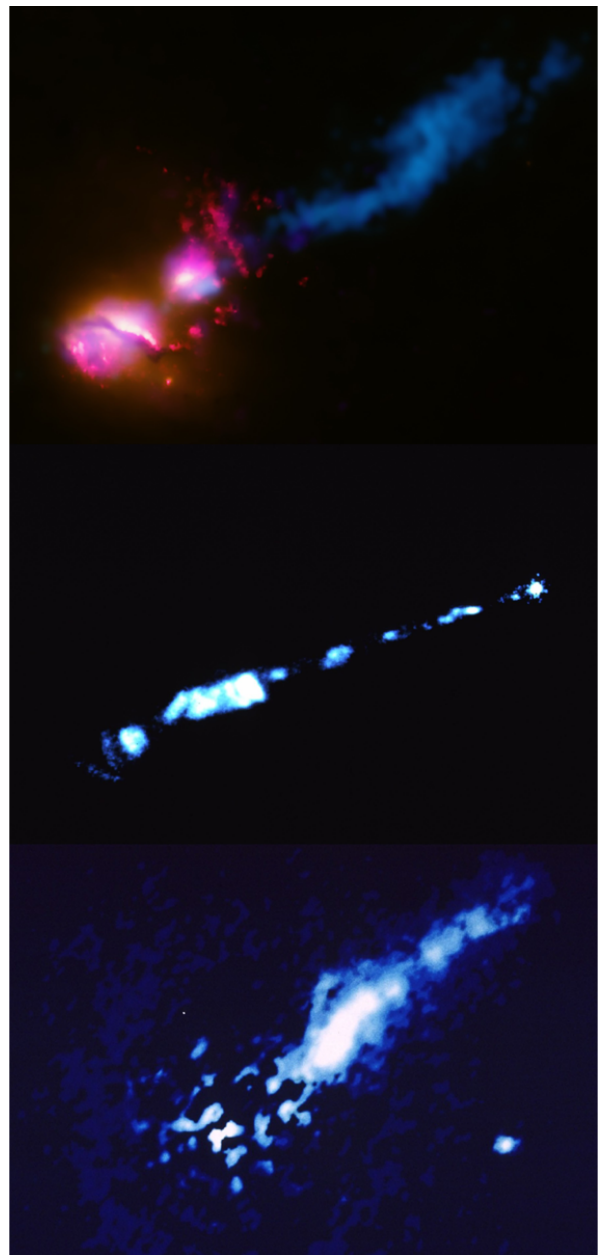
Figure 10. Hubble Space Telescope composite image showing three galactic jets, lengths, top to bottom, 865000 light years, 4000 light years, and 10000 light years.